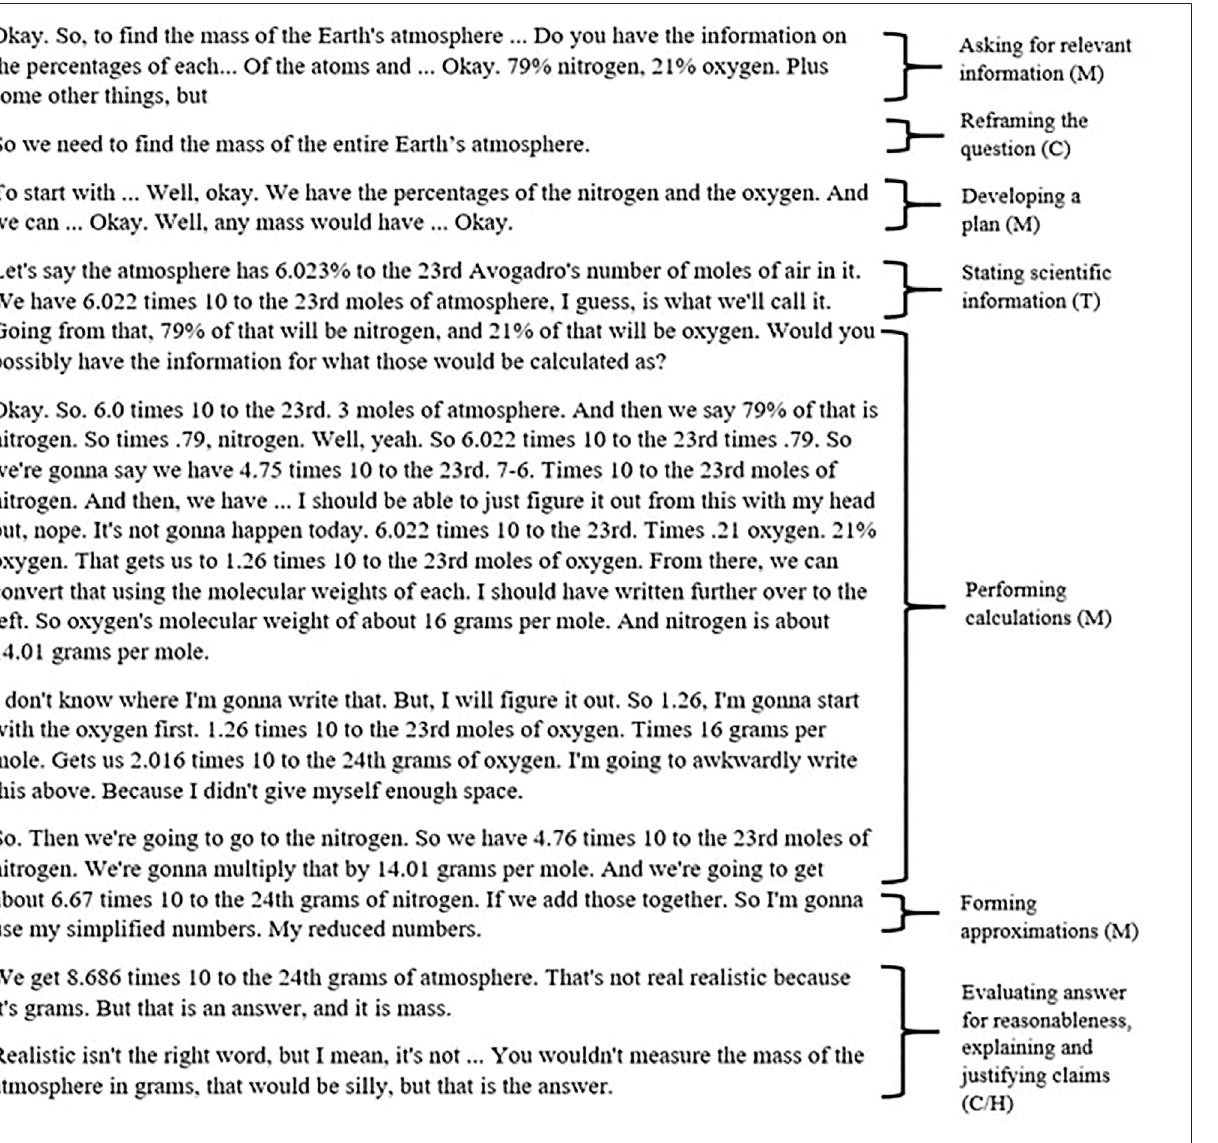
Frontiers in Education |